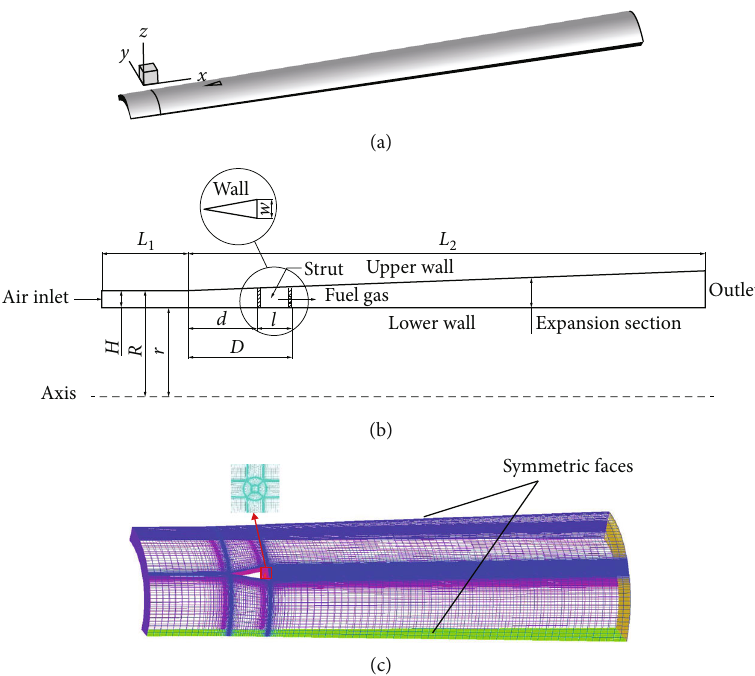
Figure 1: Physical model of the SFRJ used in this